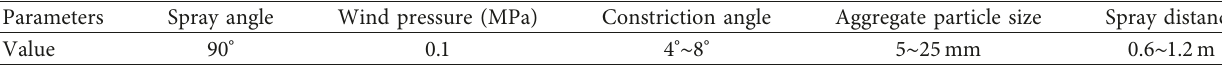
Figure 2: Nozzle diagram. Table 2: Experimental parameters.